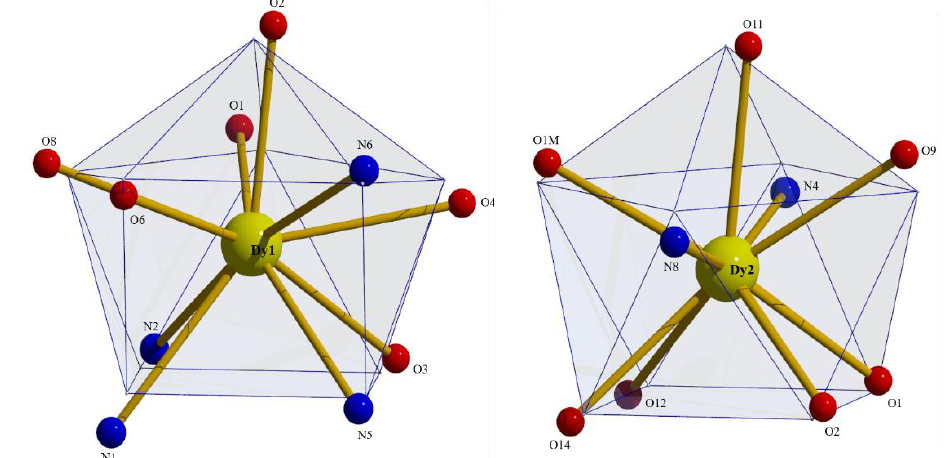
Figure 5. Molecular structure of [Er 2 (NO 3 ) 4 (L) 2 (H 2 O)] as found in 4 ∙3MeOH∙0.5H 2 O. Thermal ellipsoids are depicted at 50% probability level. Hydrogen atoms are omitted for clarity.